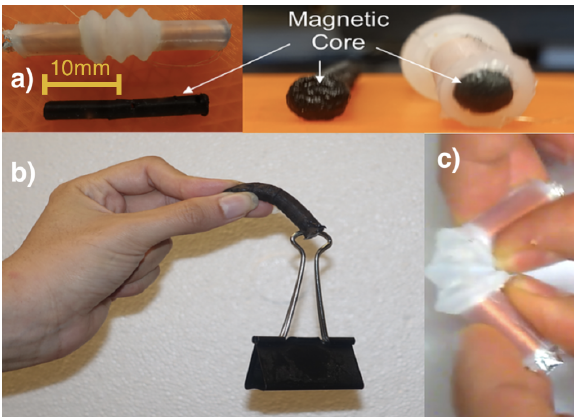
Figure 7. ( a ) A single ESA and the flexible magnet, ( b ) a flexible magnet lifting a metallic object and ( c ) a single ESA that is